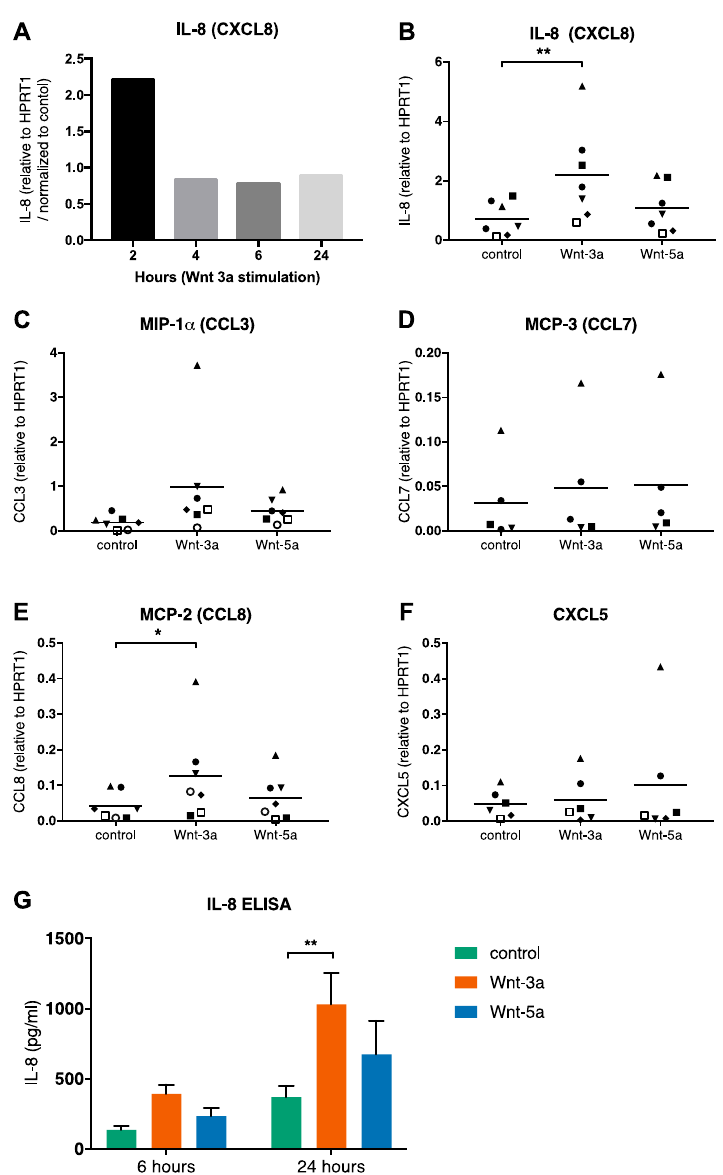
Figure 6. Wnt-3a upregulates IL-8 and CCL8 mRNA and induces IL-8 protein secretion. CBMCs were treated for 2 h (unless otherwise stated) with or without 300 ng/mL Wnt-3a or Wnt-5a, and qPCR was performed for IL-8 ( A , B ), CCL-3 ( C ), CCL7 ( D ), CCL8 ( E ), and CXCL5 ( F ). IL-8 released into the supernatant was measured by ELISA; n = 6, means with SEMs ( G ). Each symbol ( B – F ) represents data from an individual cord blood donor, n = 5–7. * p < 0.05; ** p < 0.01;